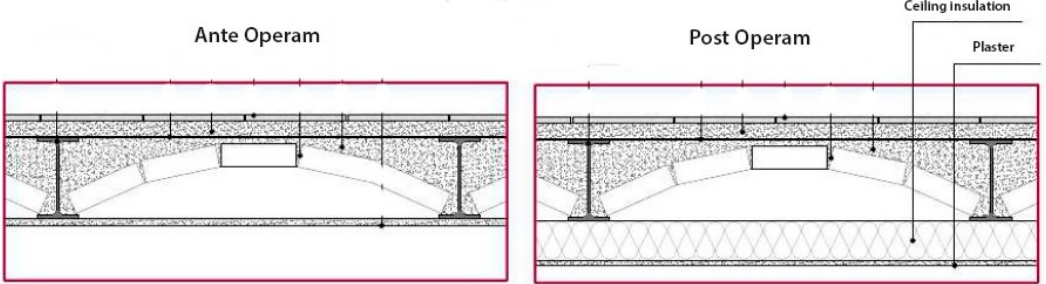
Figure 3. Villa Sciarra ceiling stratigraphy before and after the insulation intervention.